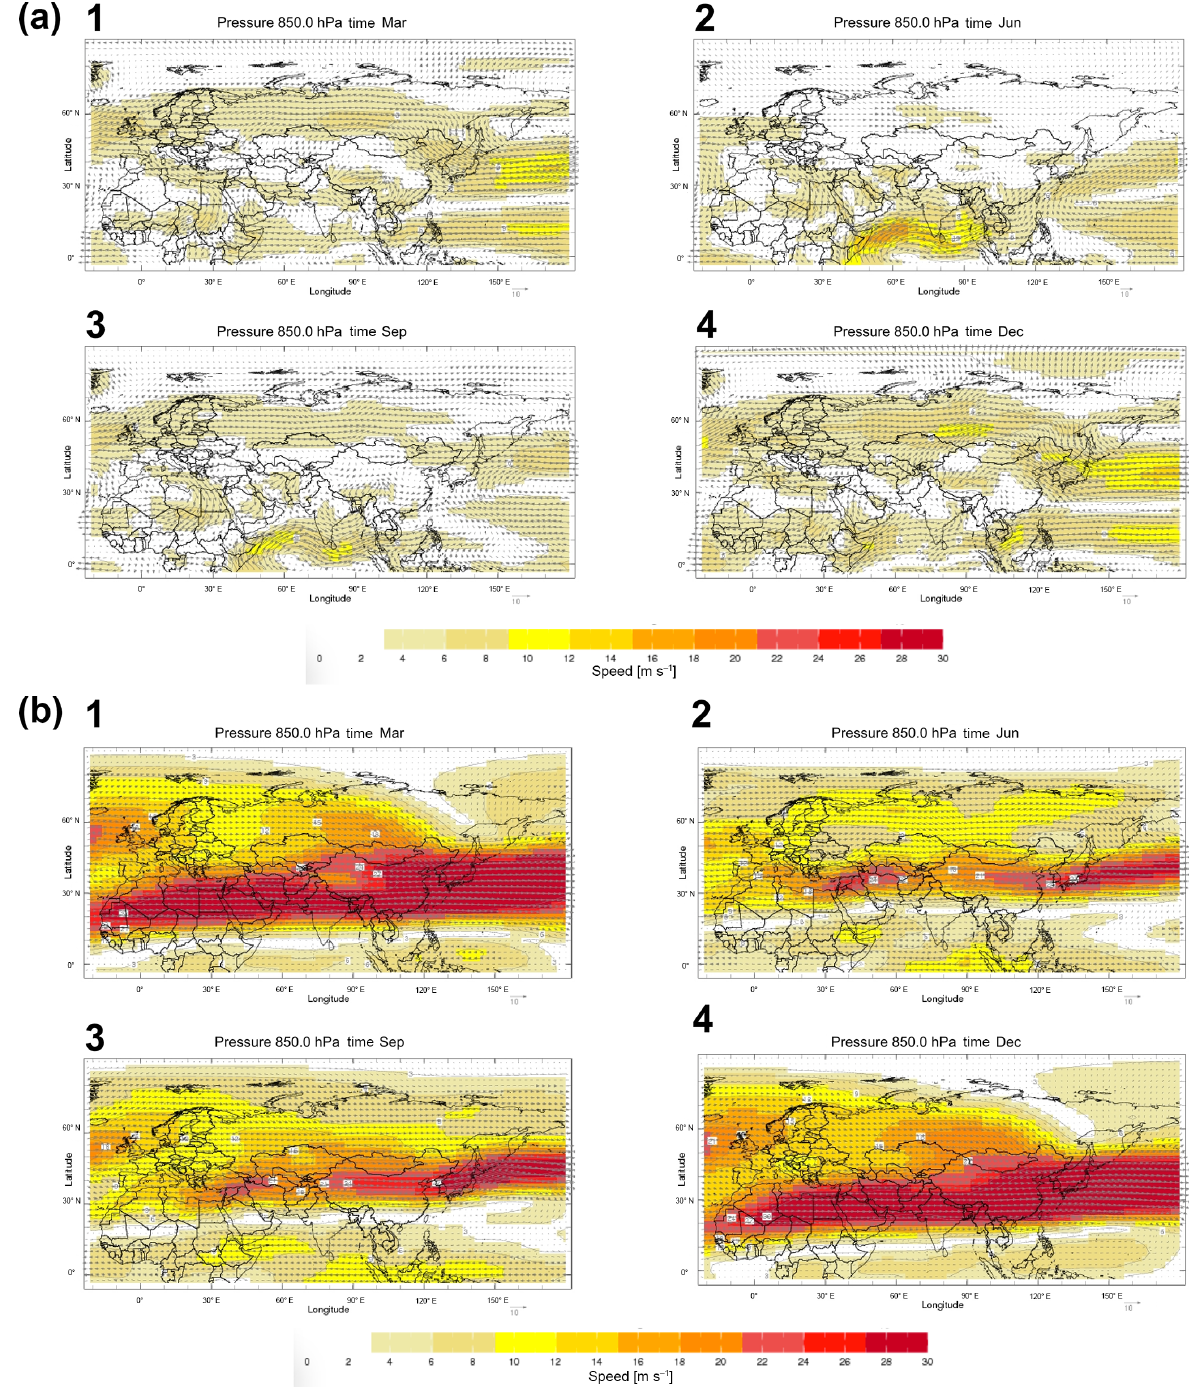
Figure 5. Impact of Atlantic climate conditions over Eurasia. Modern monthly average wind speed (ms − 1 ) at 850hPa (a) and at 300hPa (b) pressure levels for March, June, September, December, and April (main dust emission month) over Eurasia. Wind vectors are plotted over shading and contours at 3ms − 1 intervals. Data source: NCEP reanalysis monthly wind components on a 2.5 ◦ × 2.5 ◦ long and lat grid for the interval